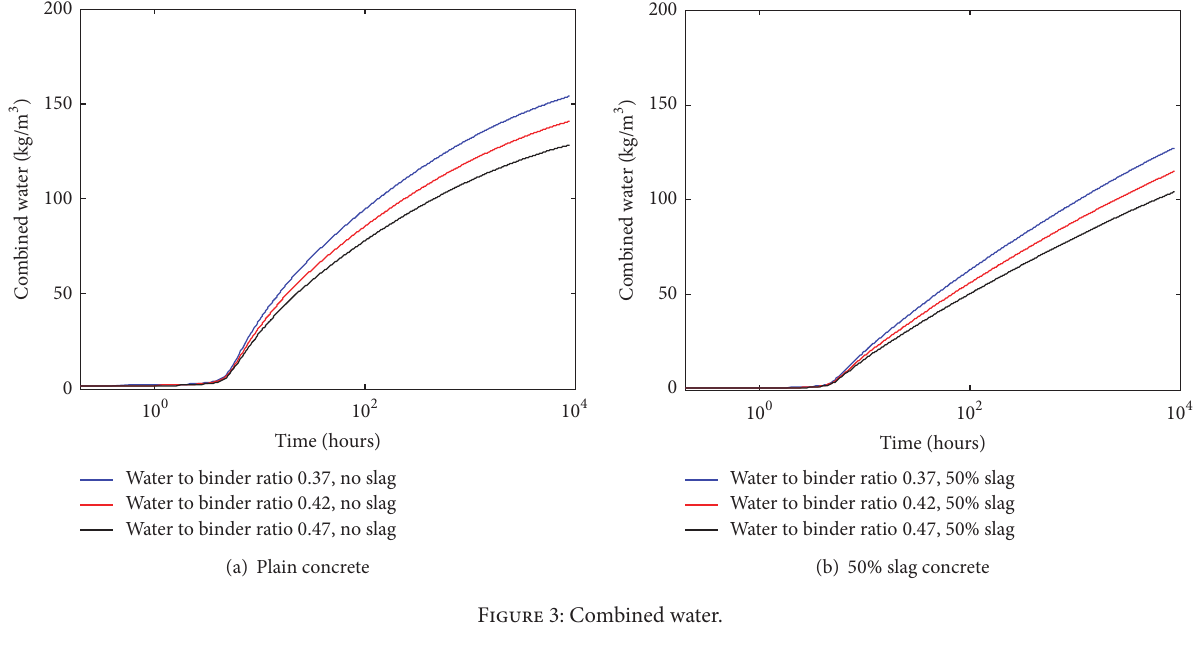
Figure 3: Combined water.